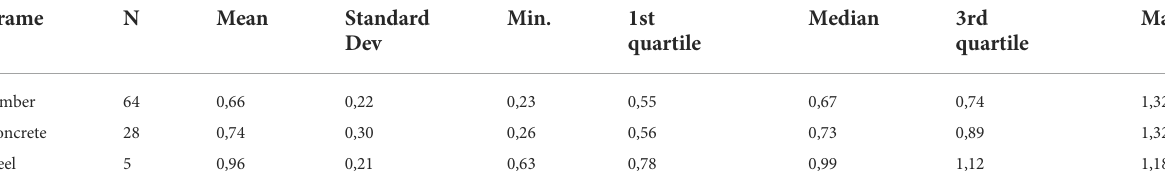
TABLE 4 An overview of GJ/m 2 /year operational energy of buildings.